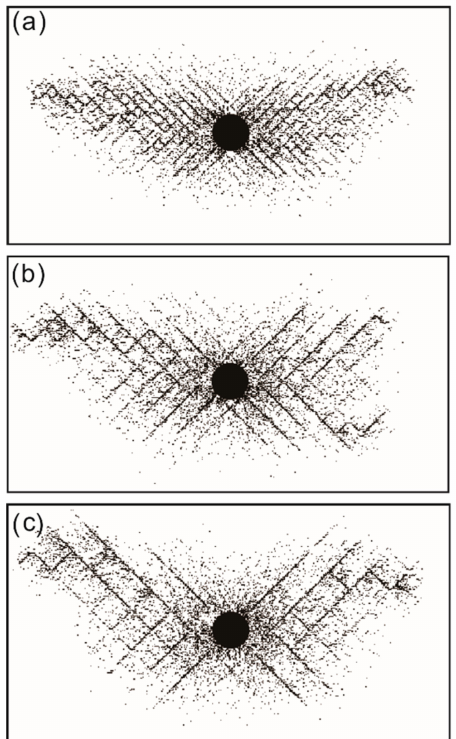
Figure 15. Failure pattern for models with two orthogonal sets of structural planes with di ff erent spacings. The boundary stress and injection rate were the same as with the base model. ( a ) Bedding spacing is the same as the hole radius ( d = r ); ( b ) Bedding spacing is two times of the hole radius ( d = 2 r ); ( c ) Bedding spacing is two times of the hole radius ( d = 3 r